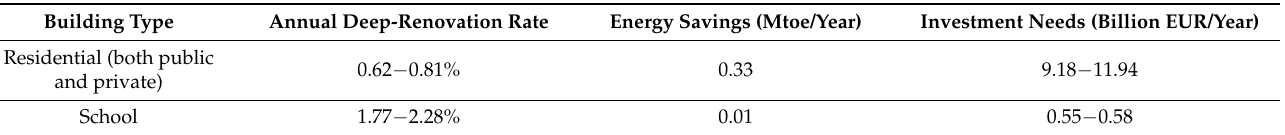
Table 5. Estimates of annual deep-renovation rates, energy savings and investment needs for residential and school buildings in 2030